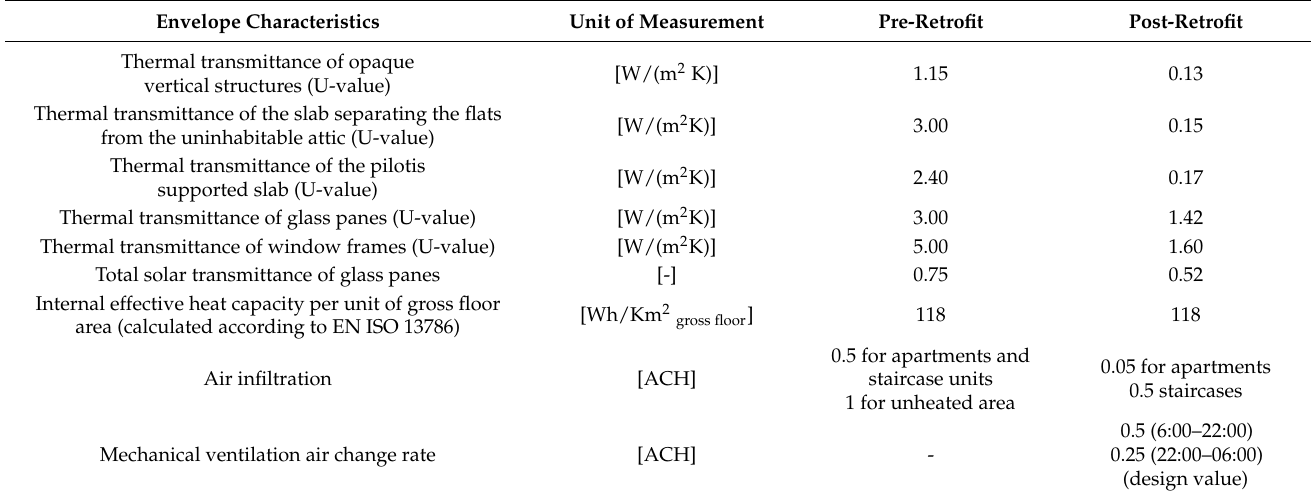
Table 4. Thermo-physical characteristic of the building (before and after